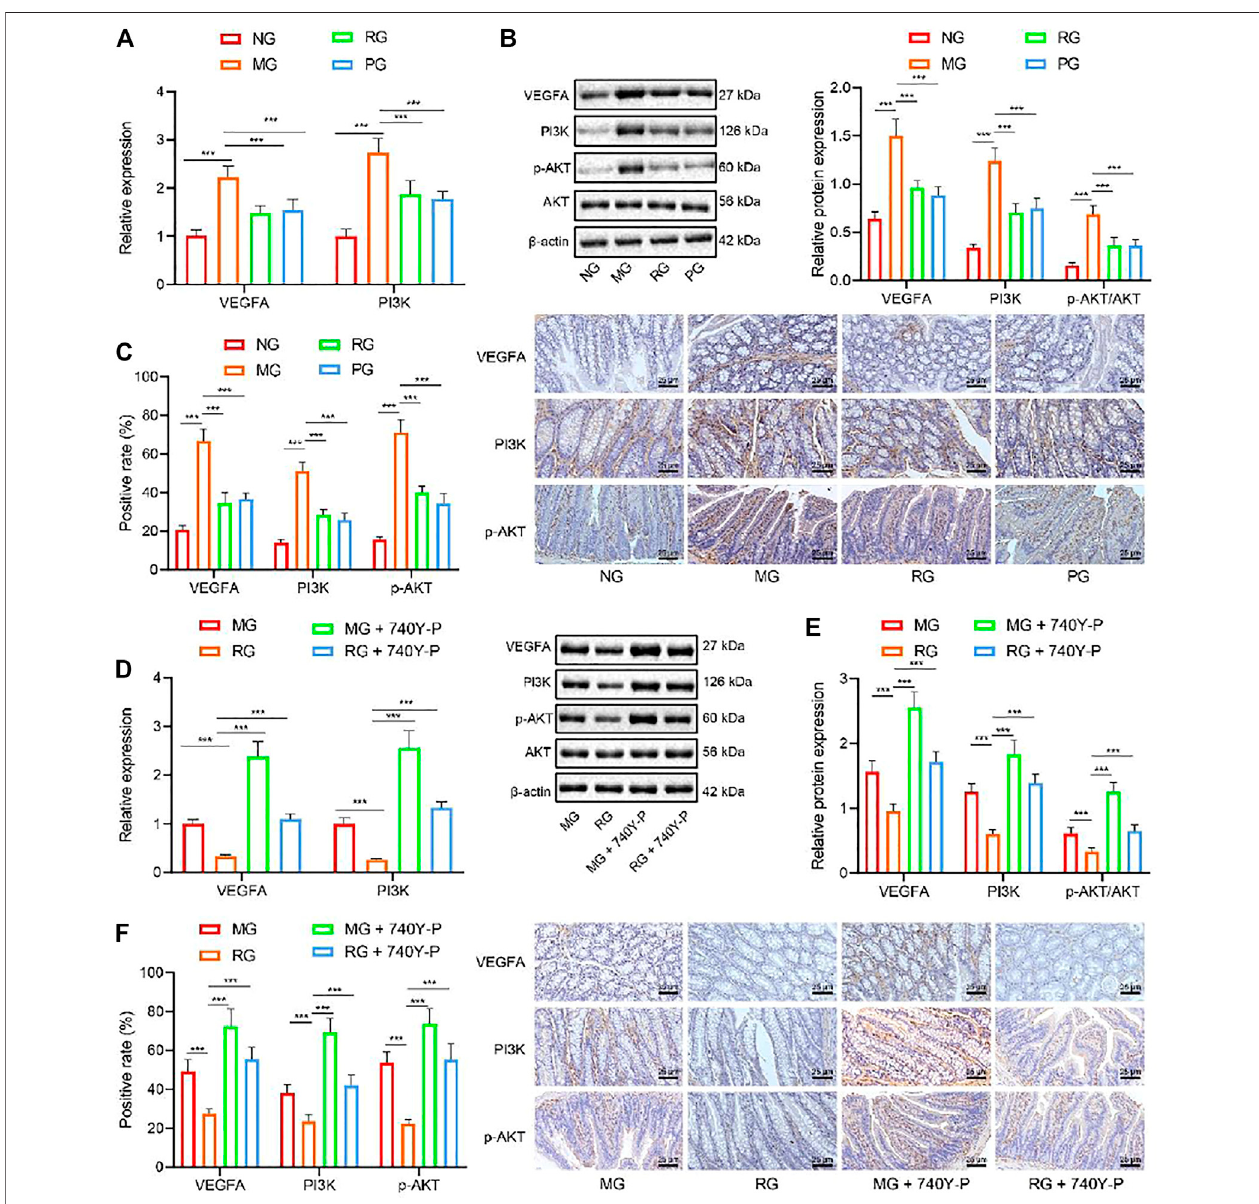
FIGURE 3 | RSV inhibits the PI3K/Akt pathway activation and reduces the VEGFA gene expression. (A) The expression of VEGFA and PI3K and genes in colon tissueswasanalyzedbyRT-qPCR. (B) Theexpression ofVEGFA,PI3K,p-Akt,andAktproteinincolontissueswasdetectedbyWesternblotanalysis. (C) Expressionof VEGFA and Akt protein in colon tissues was analyzed by IHC. (D) The expression of VEGFA and PI3K in colon tissues after the addition of PI3K/Akt activator was determined with RT-qPCR. (E) Western blot analysis of the expression of VEGFA, PI3K, and p-Akt/Akt ratio was in colon tissues after the addition of PI3K/Akt activator. (F) The expression of VEGFA and p-Akt protein in colon tissue after adding PI3K/Akt activator was determined with IHC. # p < 0.05 vs . VEGFA, PI3K, and Akt expression in MG. ## p < 0.01. n (cid:1) 20. Measurement data were expressed by mean ± SD. One-way ANOVA was conducted for multiple group comparison, followed by Tukey ’ sposthoctest.NG,normalcontrolgroup;MG,modelcontrolgroup;RG,resveratrolgroup;PG,positivecontrolgroup;VEGFA,vascularendothelialgrowthfactor A; 740Y-P, PI3K/Akt activator.